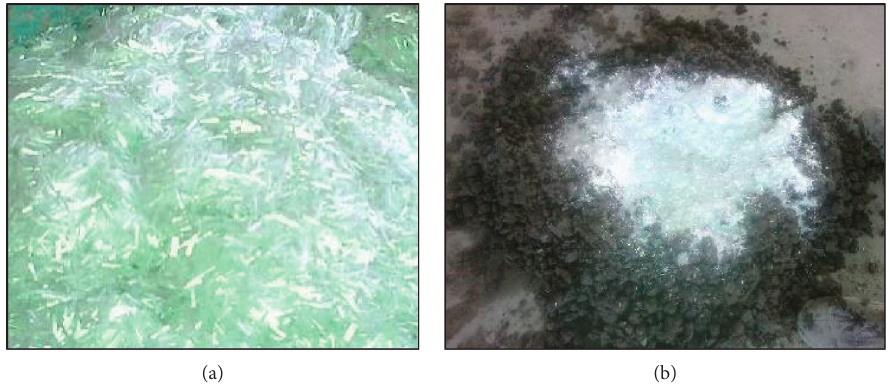
Figure 2: Glass fiber mixing procedure. (a) Dispersing of the glass fiber in the water; (b) mixing with concrete.